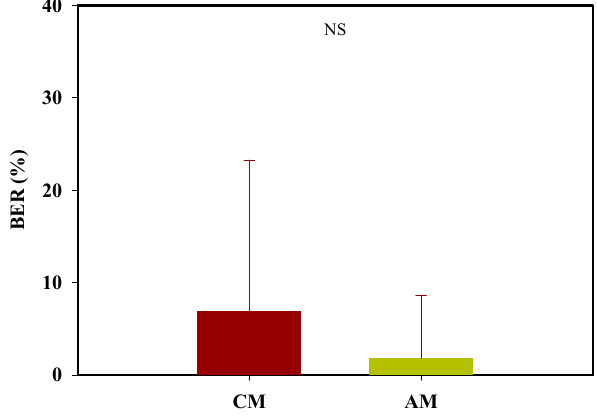
Figure 10. Comparison of blossom-end rot (mean ± SD ) of sweet pepper between conventional (CM) and alternative (AM) nutrient-replenishment methods ( t -test). NS: Not significant.